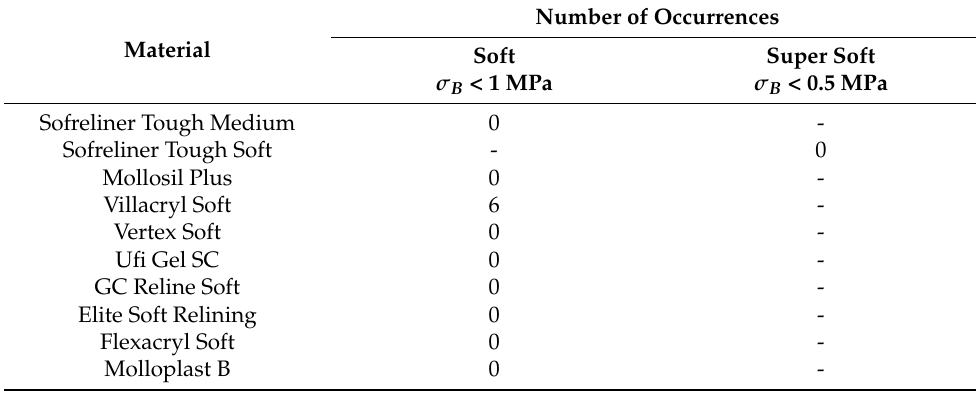
Table 1. Checking the degree of compliance with the requirements of ISO 10139-2 by the analyzed materials in terms of the strength of the connection with the material for denture plates.